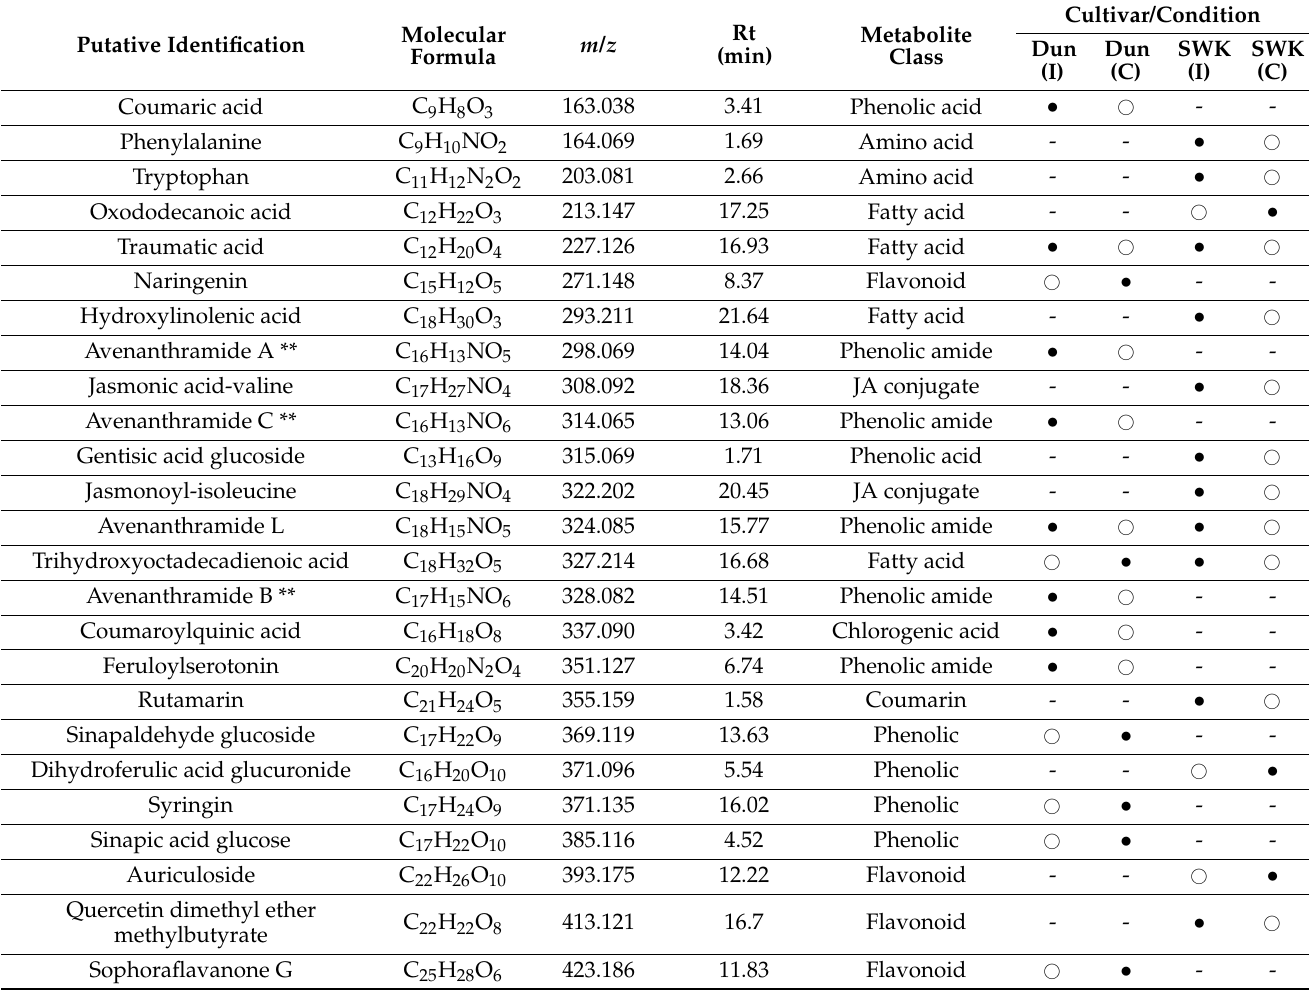
Table 1. List of key signatory metabolites extracted and putatively identified from leaves of oat plants treated with Pseudomonas syringae pv. coronafaciens . These distinguishing metabolites were selected using OPLS-DA S-plots, which were validated with rigorous statistical validation methods (explained in text—Figure 5). The metabolites reported here had VIP scores >1.0. Increases and decreases are indicated for each treatment where infected (I) and controls (C) were compared for the cultivars “Dunnart”- Dun and “SWK001”-SWK.